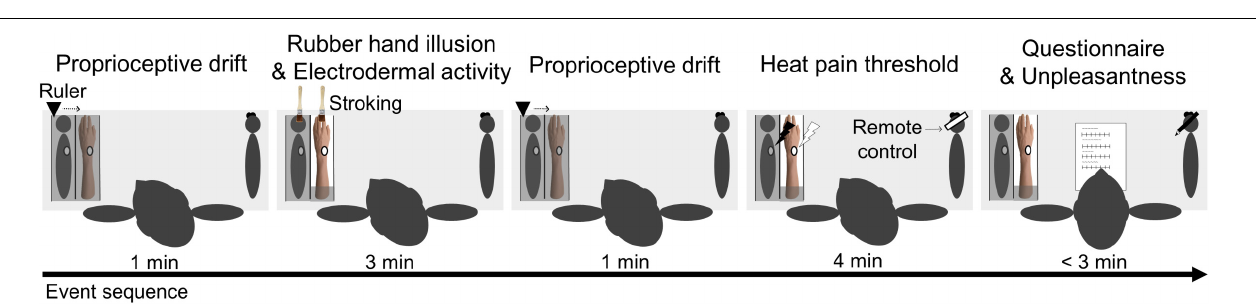
F 1 , 14 = 1.33, p = 0.27, η p 2 = 0.087) or ILLUSION (synchronous